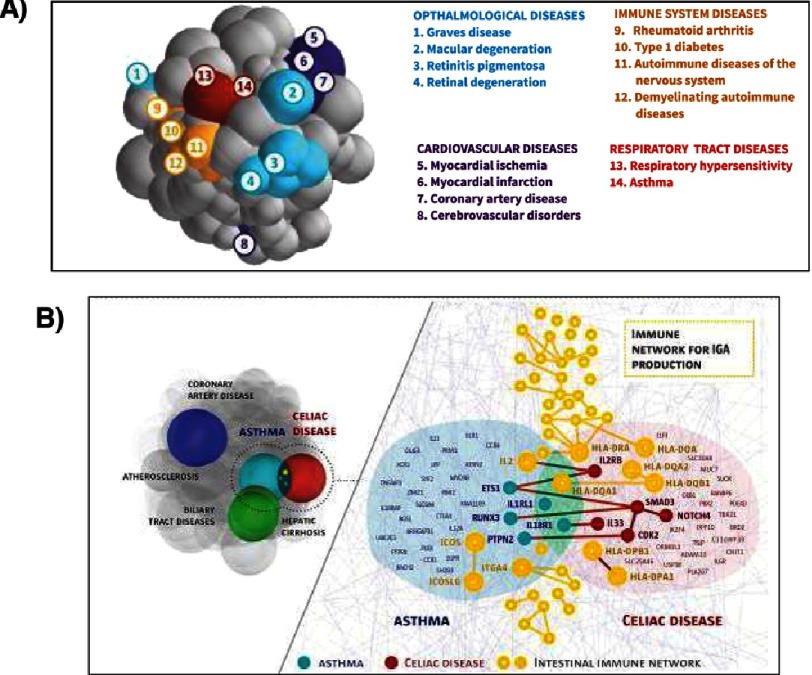
(A) A 3-dimensional representation of the relationship between diseases in the consolidated human interactome by Meche and colleagues39.In this analysis, the physical distance between diseases is proportional to the shortest distance between closely connected protein pairs across disease modules. Diseases whose modules (spheres) overlap are predicted to have a common molecular pathobiology. (B) This methodology identified unexpected overlap between certain diseases, such as hepatic cirrhosis, asthma, and celiac disease (left). A network-level map demonstrates the biological/immunological basis of overlap between in the asthma-celiac disease network-neighborhood. Figure and legend reproduced with some modifications from39 with permission pending.